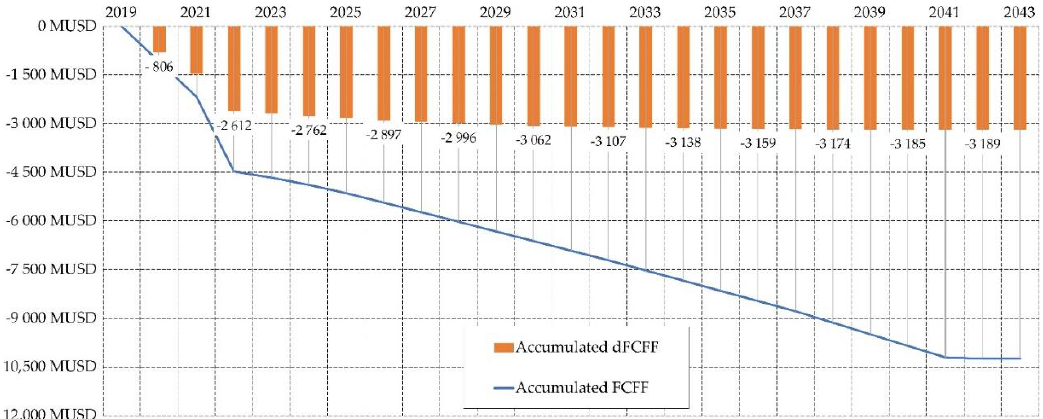
Figure 6. The results of the economic analysis (accumulated cash flow) of scenario 1—HM, FCFF—free cash flow for the firm, dFCFF—discounted FCFF (QVISTORP growth, QVISTORP calculation).